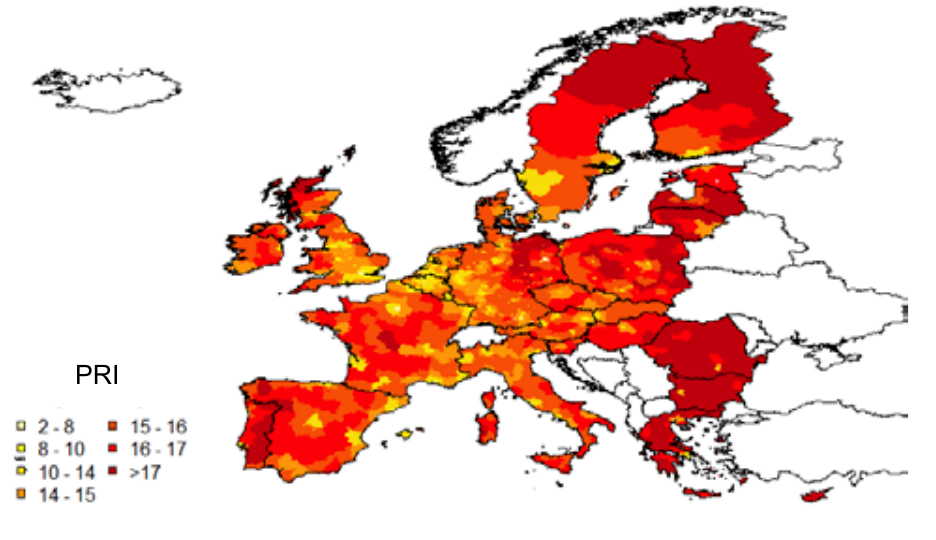
Figure 2. PRI values across EU NUTS 3